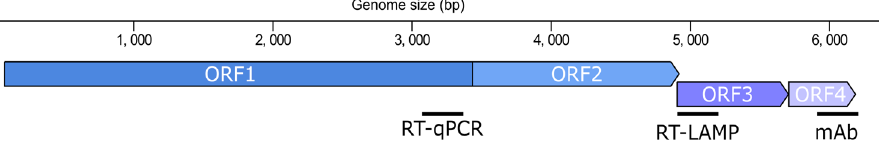
Figure 1. Genome organization of ToBRFV and regions targeted by the different tests (RT-qPCR, RT-LAMP, and ELISA). RT-qPCR was directed to the 3 ′ end of the large fragment of the RdRP (ORF1), RT-LAMP to the start of the MP (ORF3), and ELISA against the C-terminus of the CP, which is the gene product of ORF4.